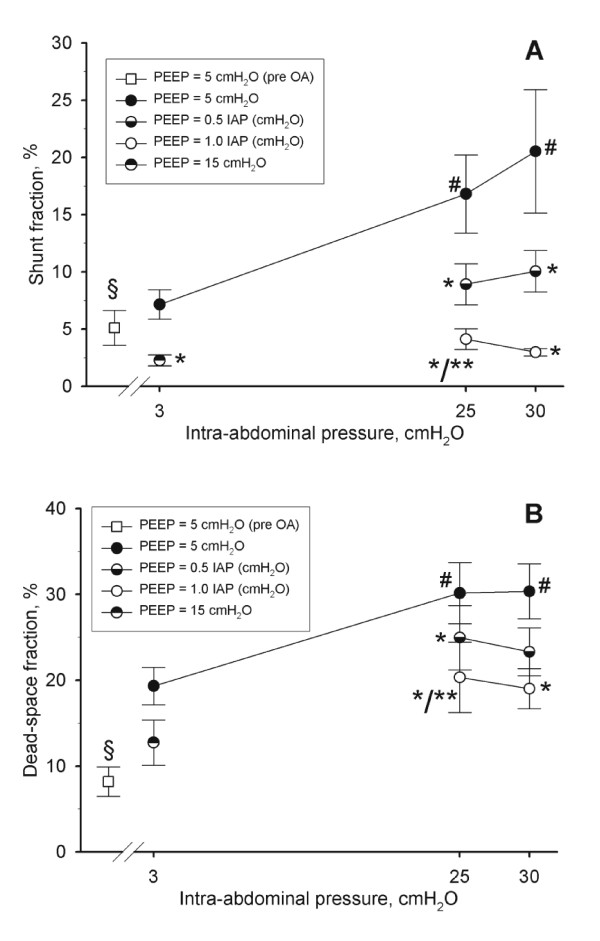
Shunt fraction in % (A) and dead-space fraction in % (B) in function of different levels of intra-abdominal hypertension (IAH) (baseline (3 cmH2O), grade II IAH (25 cmH2O = 18 mmHg), and grade III IAH (30 cmH2O = 22 mmHg)) at different degrees of IAP-matching levels of positive end-expiratory pressures (PEEP). Mean and SE are shown. ANOVA and post hoc Student-Newman-Keuls were used for statistical testing. §, P <0.05 comparing before and after oleic acid (baseline IAP and 5 cmH2O PEEP). *, P <0.05 within an IAP setting versus the corresponding value at 5 cmH2O PEEP. **, P <0.05 within an IAP setting comparing moderate versus high PEEP. #, P <0.05 within a PEEP setting versus the corresponding value at baseline IAP. ANOVA, analysis of variance.